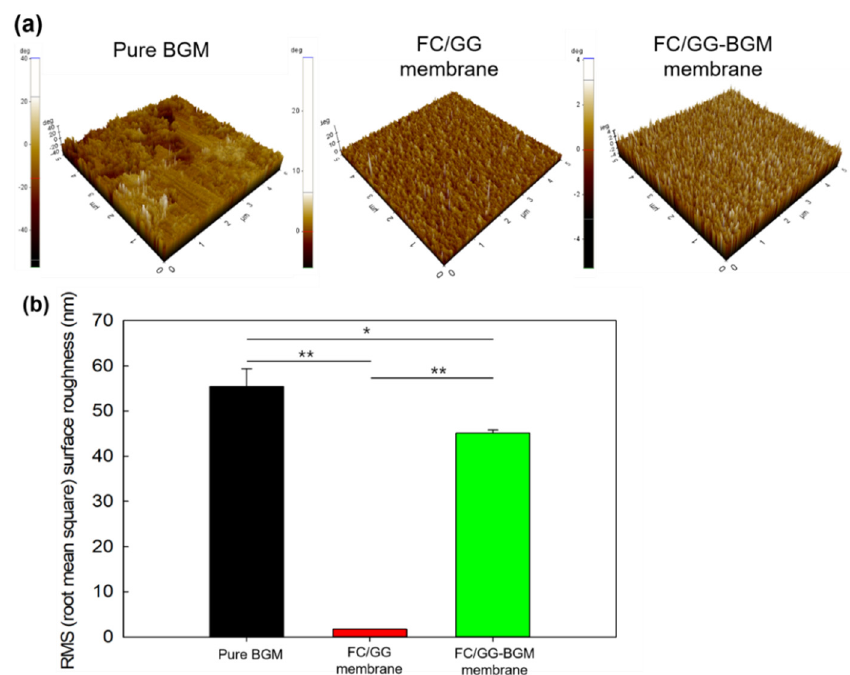
Figure 5. ( a ) 3D surface images of pure BGM, FC/GG membrane, and FC/GG-BGM membrane. Surface morphology and profile observed at three points (5 µ m × 5 µ m area per point) of each sample using AFM. ( b ) Surface roughness (below graph) of pure BGM, FC/GG membrane, and FC/GG-BGM membrane calculated from the value of the surface profile using the root mean square formulation. Data are reported as the mean ± SD of three replicates. (* p < 0.05, ** p < 0.01).